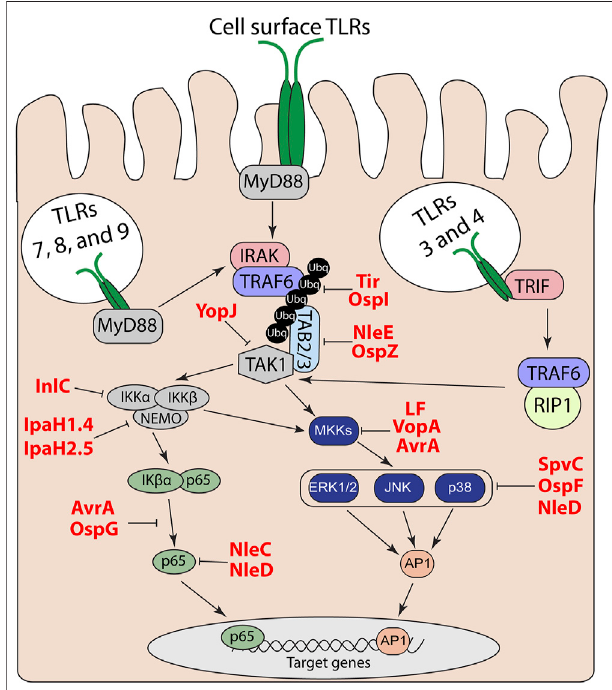
FIGURE 1 | TLR and MAP kinase/NF-kB signal transduction pathways. Effector regulation of TLR signaling through inhibition of MAP kinase and NF- κ B pathways to suppress downstream proin fl ammatory target